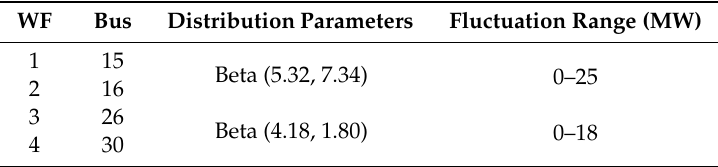
Table 2. Uncertainty descriptions of wind farms